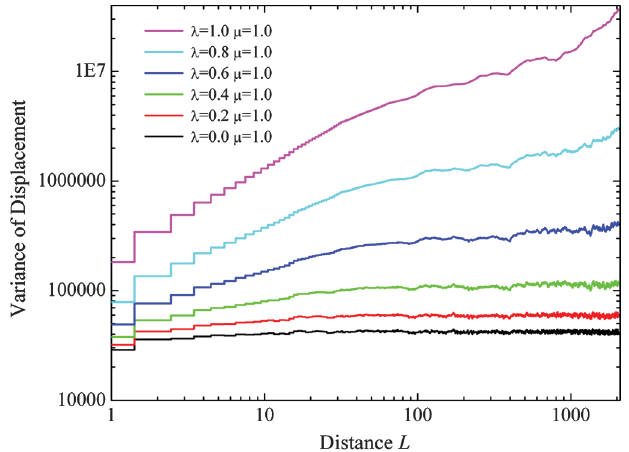
FIG. 47. (Color) Variance of the displacements vs distance be- tween points after 16 000 steps for different scaling exponents (cid:4) and (cid:7)